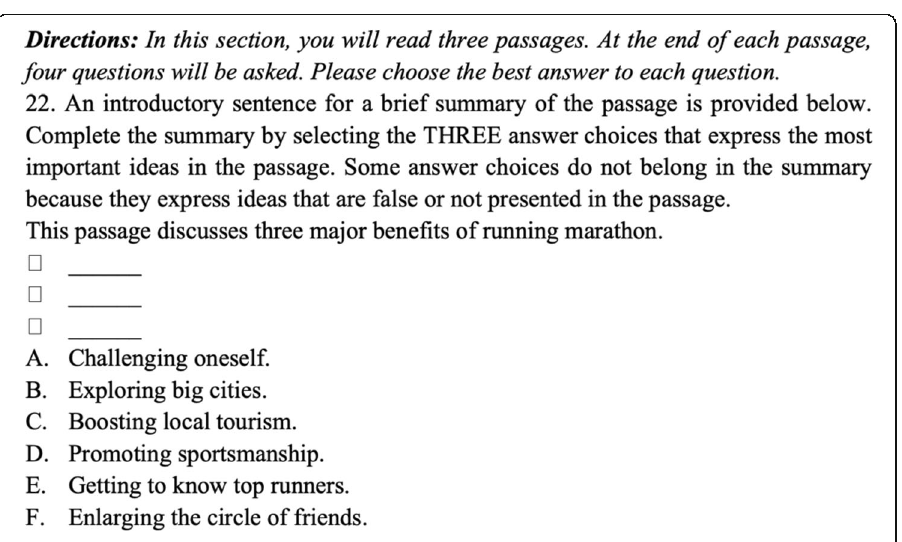
Fig. 2 An example question from the UDig reading